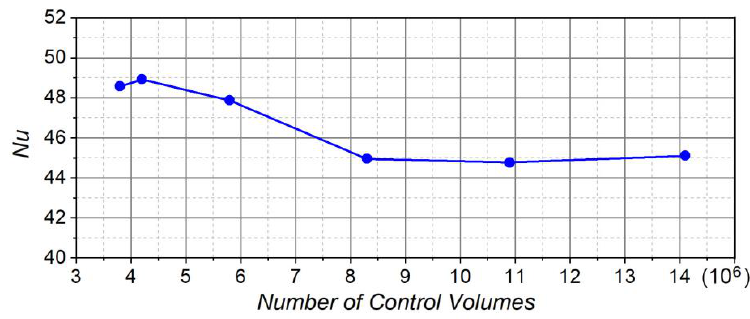
Figure 4. Nu at mesh independence analysis.